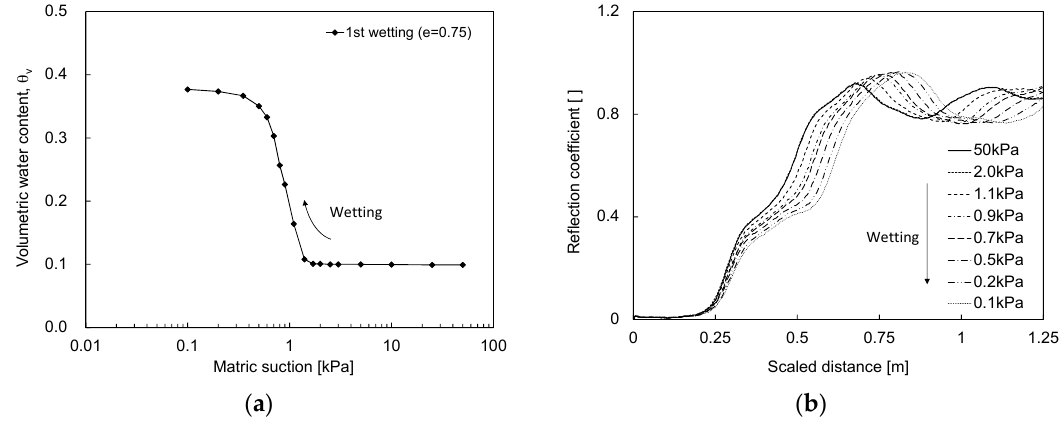
Figure 7. SWCC and TDR waveform during the wetting process: ( a ) SWCC; ( b ) TDR waveform.